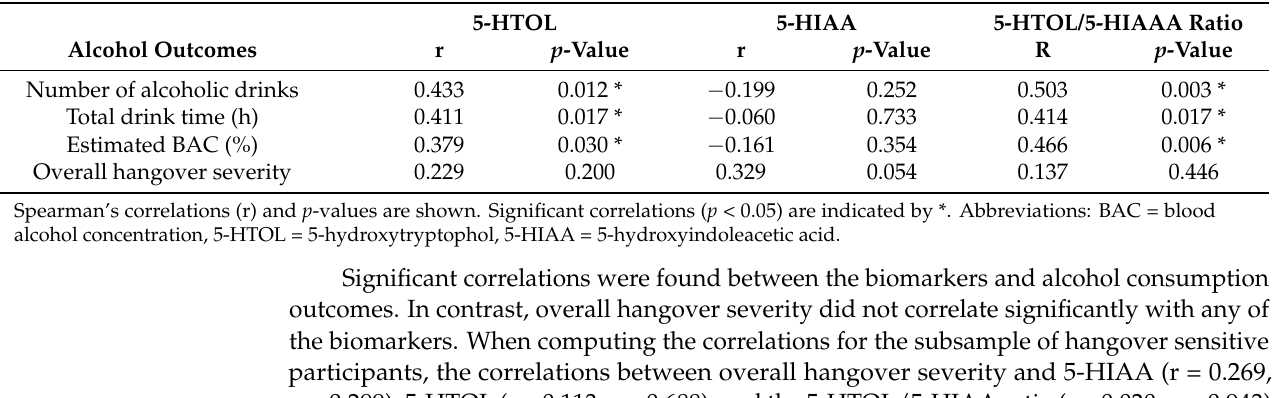
Table 4. Correlations between biomarkers and alcohol consumption